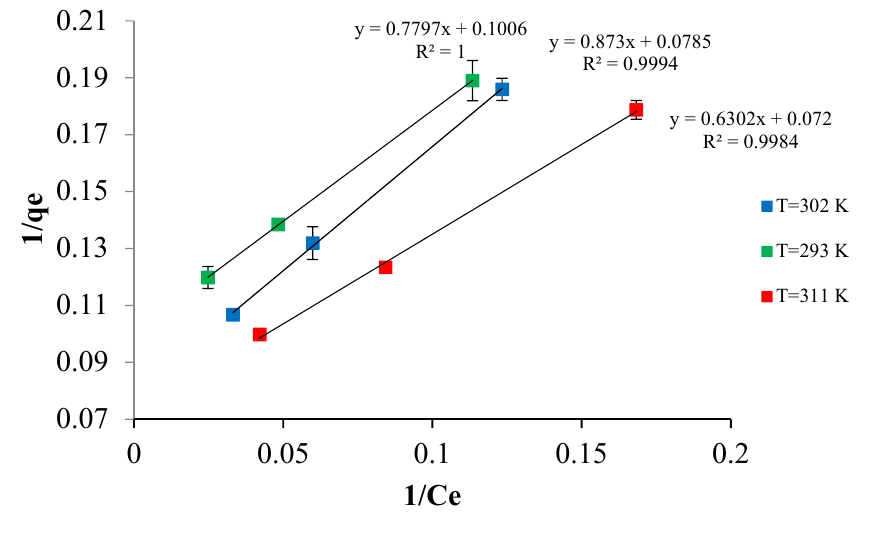
Figure 15. Langmuir linear isotherm representation (adsorbent dose 1% by weight, pH 5.0, contact time 24 h). Table 5. Freundlich and Langmuir parameters, ERRSQ, and regression coefficients at different tem- peratures for the adsorption of TPC by Ox-AC/Cu/Cu 2 O/CuO. Adsorption Temperature (K)